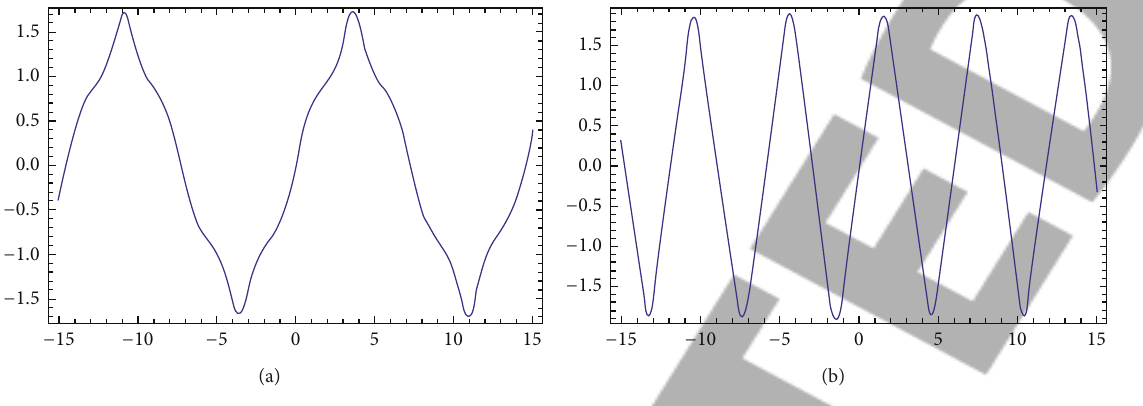
Figure 9: Simulation of periodic waves corresponding to periodic orbits outside double figure-eight loop of (7). (a) Close to double figure- eight loop. (b) Far from double figure-eight